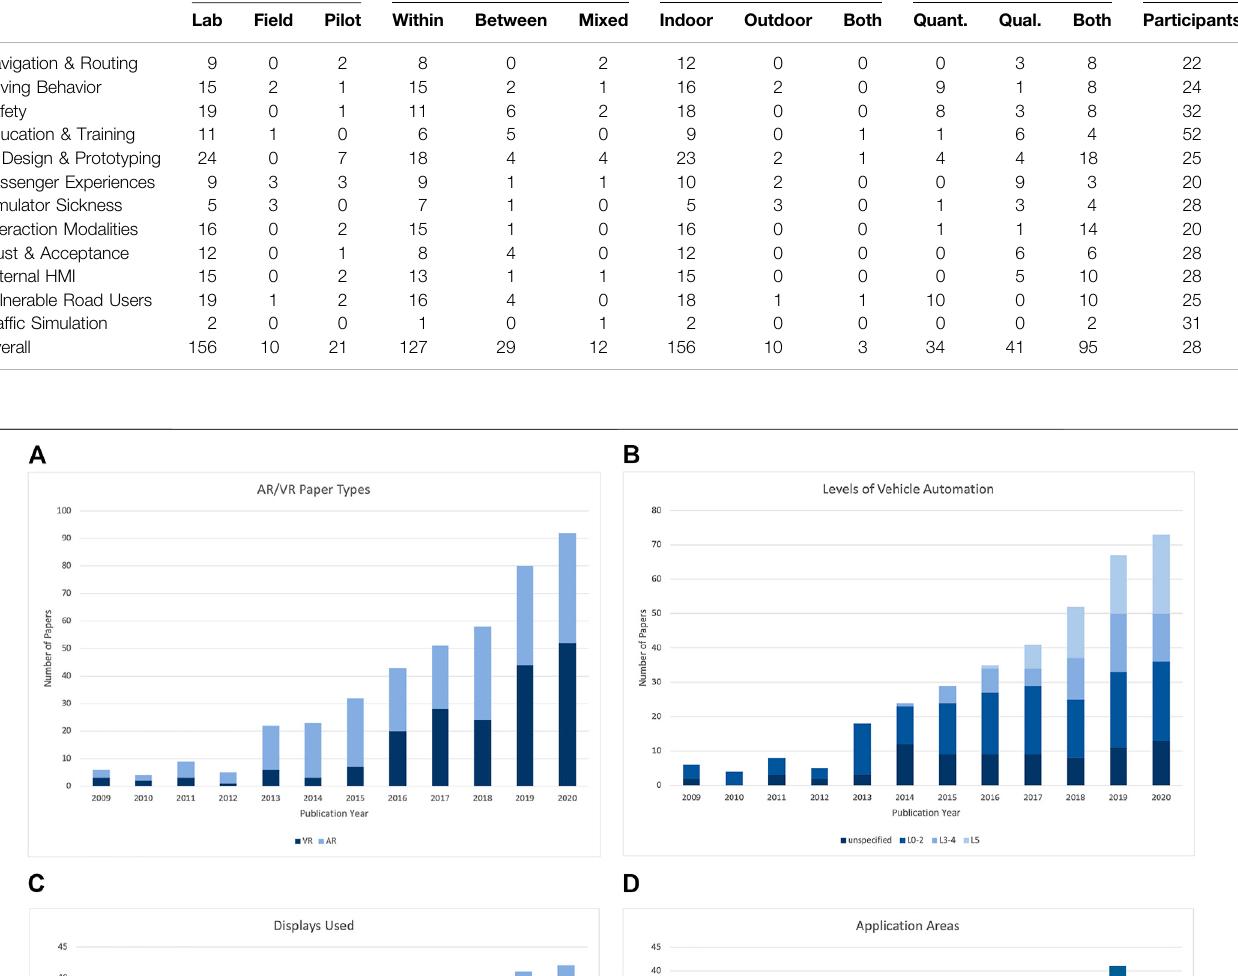
Frontiers in Human Dynamics |